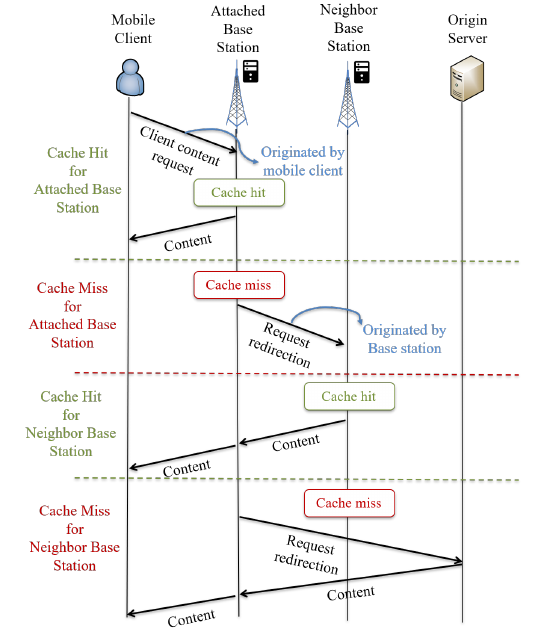
Figure 1. Request routing in Base Station based Mobile-CDN.